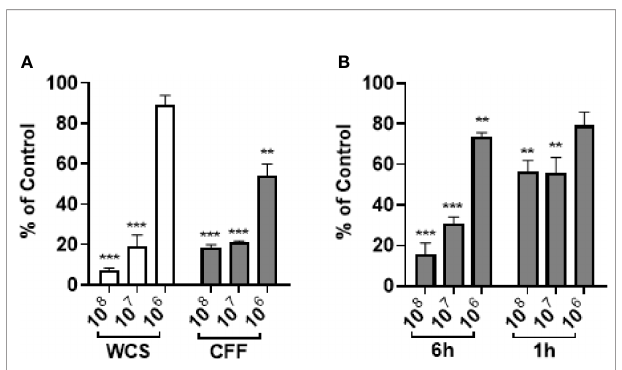
FIGURE 2 | L. acidophilus whole cell suspension (WCS) and cell free fi ltrate (CFF) removed 20 h and 48 h established P. aeruginosa bio fi lm. P. aeruginosa was incubated at 37°C for 20 h or 48 h prior to treatment with L. acidophilus WCS or CFF for 1 h or 6 h. The remaining bio fi lm was stained with 0.1% crystal violet and OD 600 was measured. (A) After 6 h treatment, 10 8 and 10 7 CFU/200 µL WCS signi fi cantly removed 20 h established bio fi lm, but 10 6 CFU/200 µL WCS did not. However, all concentrations of CFF signi fi cantly abolished 20 h bio fi lm, though 10 6 CFF was less effective. (B) Following 6 h treatment, all three concentrations of L. acidophilus CFF reduced 48 h established P. aeruginosa bio fi lm. Only 10 8 and 10 7 CFF treatments signi fi cantly removed 48 h bio fi lm after 1 h treatment. Data are mean ± s.e.m. percent change from control. **p < 0.01, ***p < 0.001; WCS n = 3 independent experiments (20 h bio fi lm, 6 h treatment); CFF n = 5 independent experiments (20 h bio fi lm, 6 h treatment); CFF n = 3 independent experiments (48 h bio fi lm, 1 h and 6 h